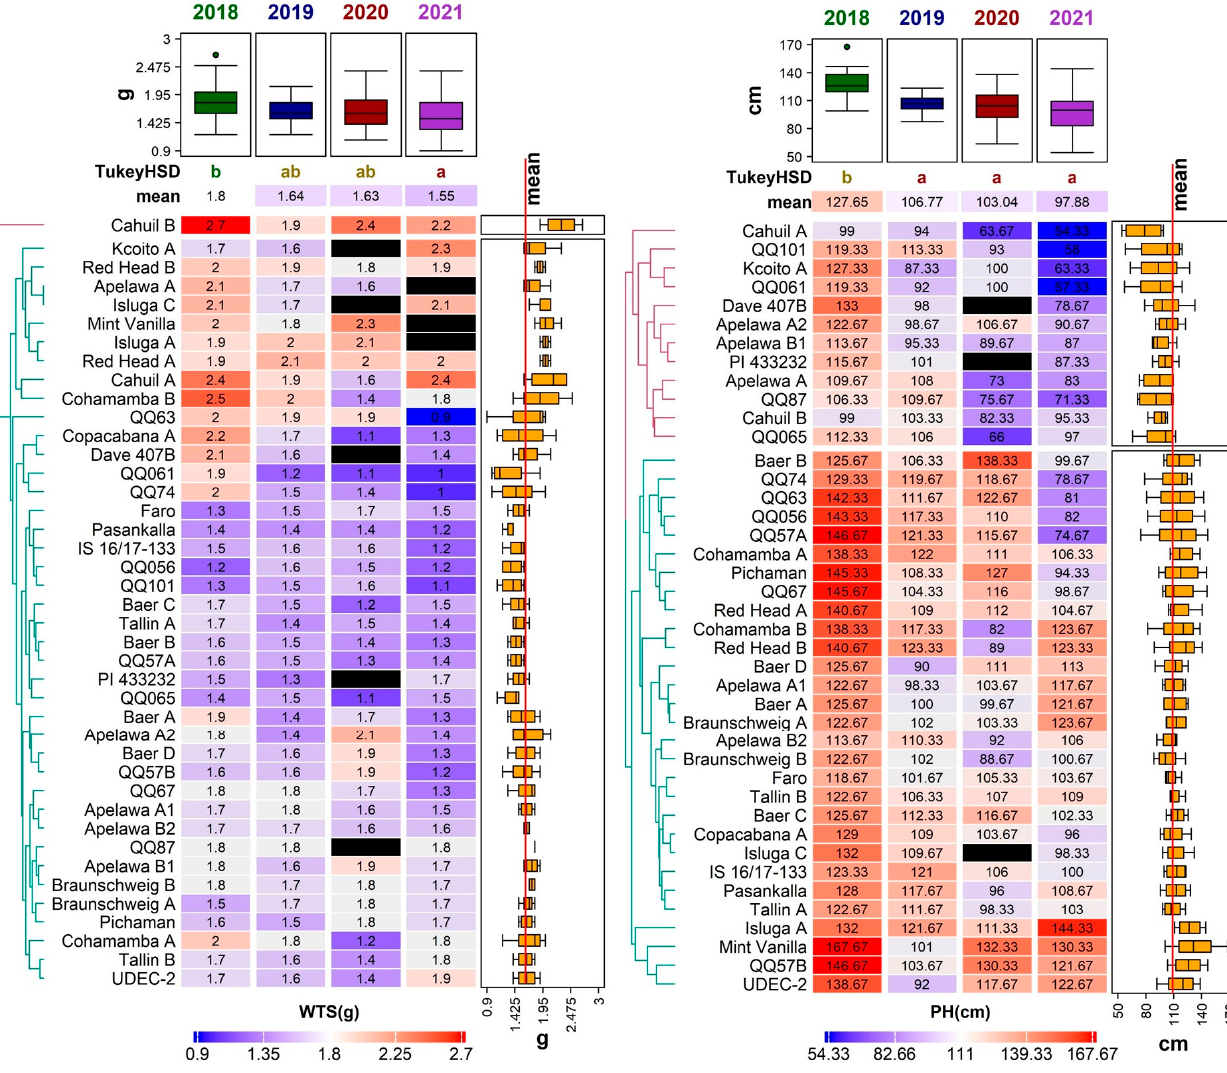
Figure 3. Diversity of 41 quinoa genotypes in terms of weight of thousand seeds (WTS, ( left )) and plant height (PH, ( right )) values, illustrated using a heatmap combined with a dendrogram based on average linkage clustering of the Euclidean distance dissimilarity matrix. Values for the respective traits are displayed on a scale from blue (min) to red (max), according to color key below each heatmap. Black rectangles indicate missing values for a given trait in a given genotype. Years with significantly different means are denoted by the different letters (Tukey HSD) above the individual columns of the respective heatmaps. Boxplots above each heatmap show the distribution of values across all accessions in individual years, while the boxplots next to each heatmap show the distribution across all years for individual accessions. The line crossing the side boxplots marks the mean of all